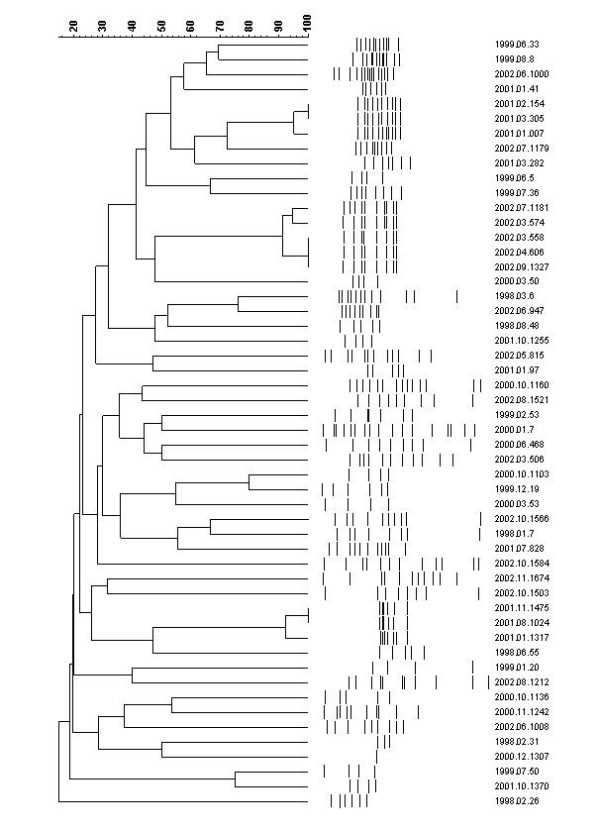
AP-PCR profiles of S. maltophilia strins including statistical analysis and dendrogram showing the genetic relationship between strains.